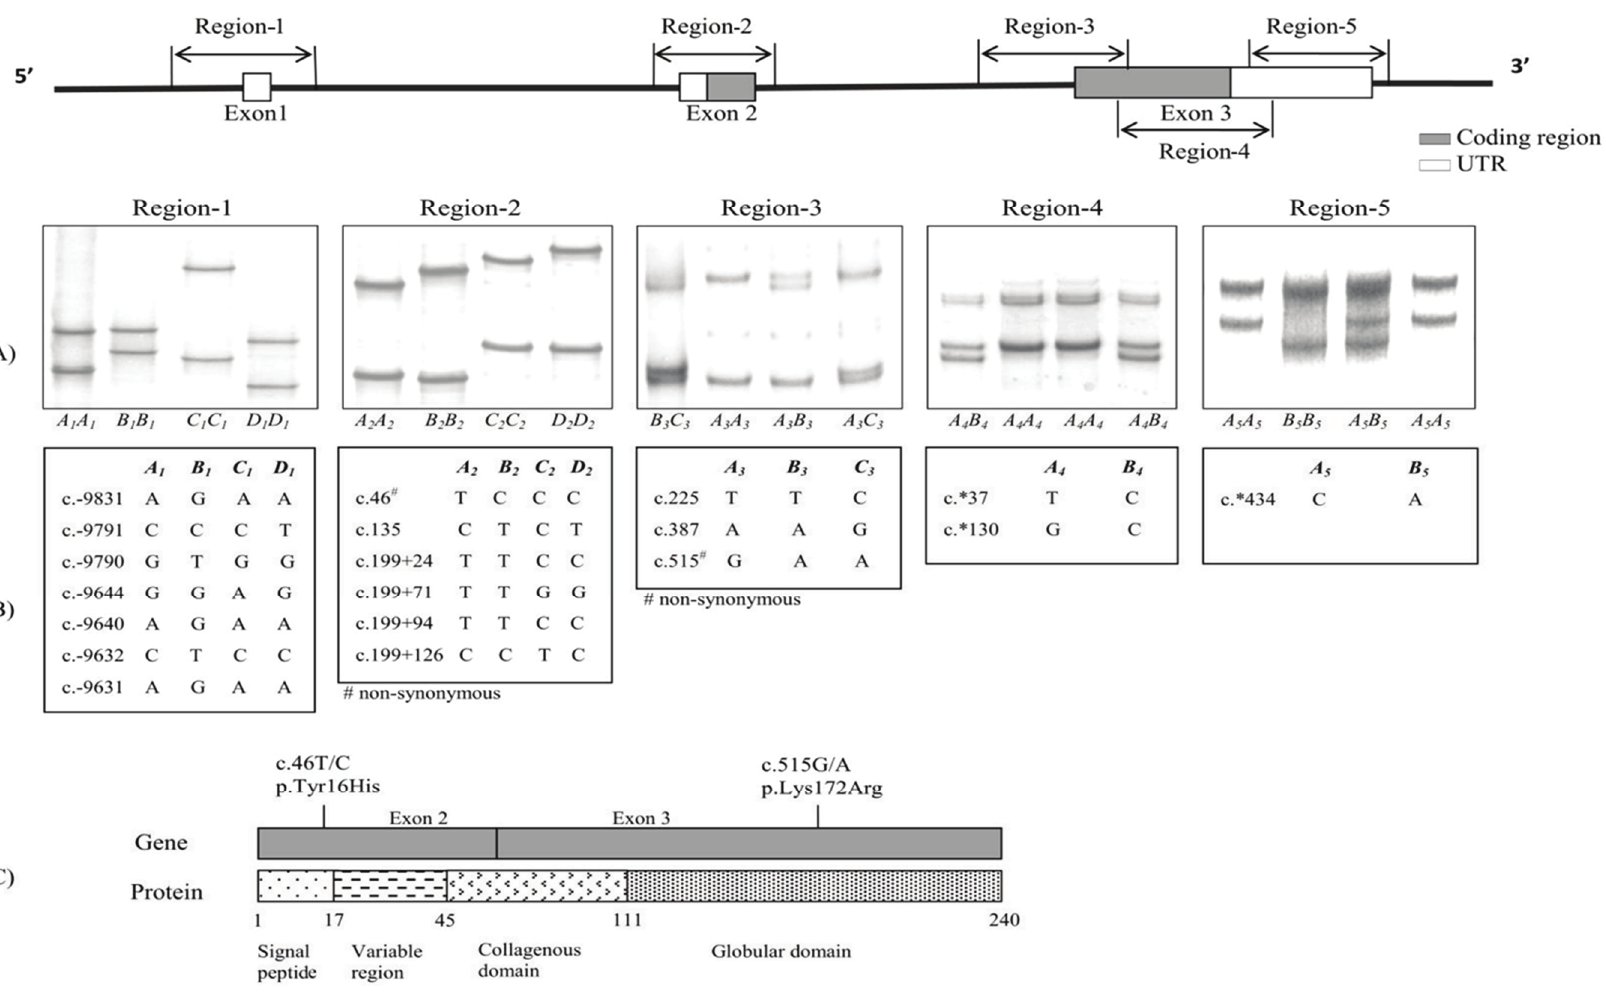
Figure 1. Variation identified in ovine ADIPOQ . Unique PCR-SSCP patterns ( A ) representing different DNA sequences ( B ) were detected in region-1 (1); region-2 (2); region-3 (3); region-4 (4); and region-5 (5). Two non-synonymous SNPs that would result in amino acid changes in the signal peptide and the globular domain were identified ( C ). The coordinates of the SNPs are annotated below the patterns based on the ovine whole genome sequence (NC_019458.1) and the numbering of positions follows the guidelines presented at